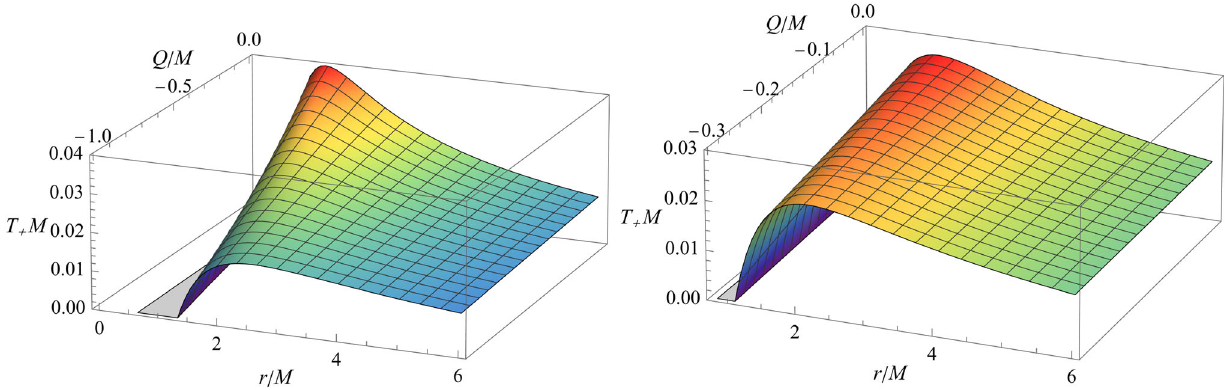
Fig. 5 Plot of temperature T + vs horizon radius r + for a = 0 . 6 M and 0 . 9 M